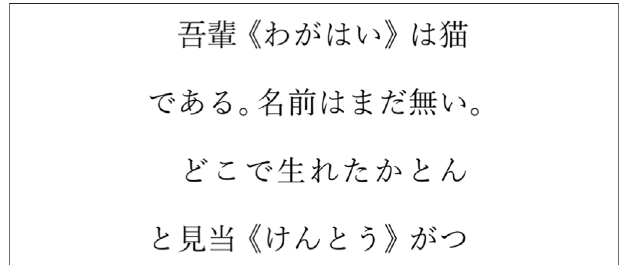
FIGURE 3 | Examples of images in the white background condition.